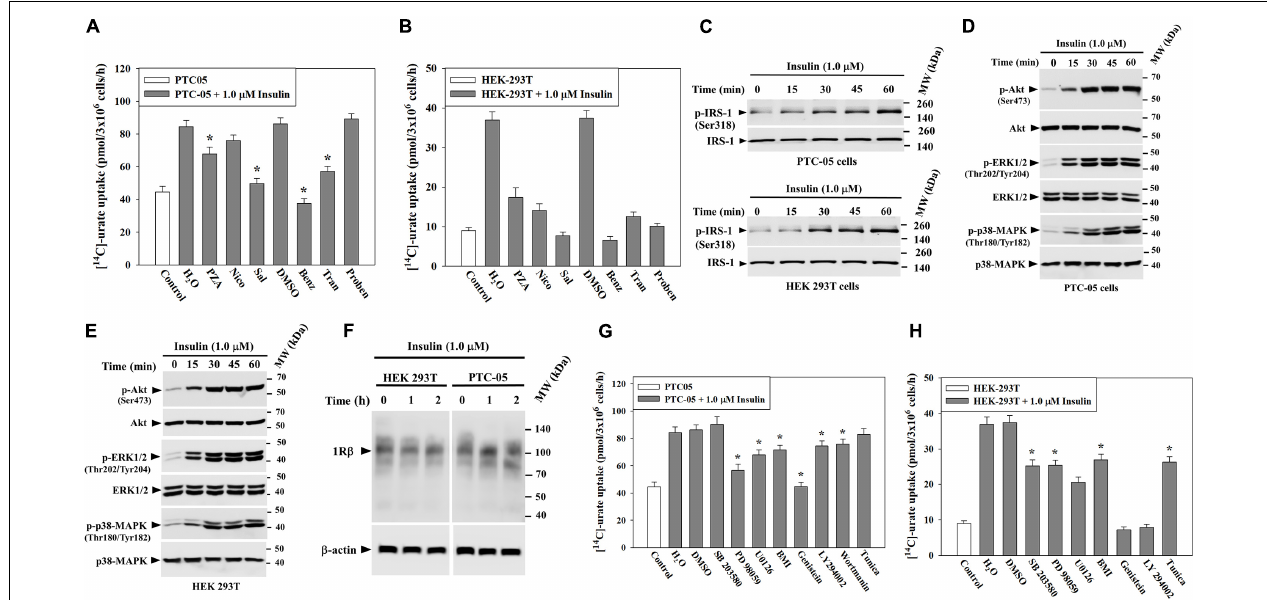
FIGURE 3 | Insulin stimulates urate uptake through activation of PTK (protein tyrosine kinase) of INSR, IRS1, PI3K, Akt, p44/42 MAPK (ERK) and/or p38 MAPK in human kidney cell lines (HEK 293T and PTC-05). (A,B) The stimulatory effect of insulin (1.0 µ M) on [ 14 C]-urate uptake by endogenous urate transporters in equal number (3x10 6 ) of PTC-05 (A) and HEK 293T (B) cells was measured in the absence and presence of 10 mM pyrazinoate (PZA), 10 mM nicotinate (Nico), 10 mM salicylate (Sal), 100 µ M benzbromarone (Benz), 100 µ M tranilast (Tran), or 1.0 mM probenecid (Proben) in the extracellular K + -free isotonic medium at ∼ 25 ◦ C. Uricosuric drugs were dissolved in dimethyl sulfoxide (DMSO). (C–E) Insulin activates IRS1, Akt, ERK and p38 MAPK in PTC-05 cells (C,D) and HEK 293T cells (C,E) . (F) Insulin has no significant effect on the expression of endogenous INSR protein (IR β ; ∼ 96 kDa) expression. For Western blot analyses cells were treated with insulin (1.0 µ M) in K + -free isotonic medium and lysates were analyzed using appropriate antibodies (see methods). (G,H) Signaling pathway-specific inhibitors differentially inhibit insulin-stimulation of [ 14 C]-urate uptake in PTC-05 cells (G) and HEK 293T cells (H) . The effect of insulin (1.0 µ M) on [ 14 C]-urate uptake was measured in K + -free isotonic uptake medium in the absence and presence of the natural protein tyrosine kinase inhibitor (genistein; 75 µ M), phosphatidylinositol 3-kinase (PI3K) inhibitor (LY 294002; 50 µ M), wortmanin (4 µ M), p38 MAPK inhibitor (10 µ M SB 203580), MEK/ERK inhibitor (20 µ M PD 98059 or U0126) or protein kinase C inhibitor (10 µ M bisindolylmaleimide I (BMI). Results are the average of three independent experiments ± s.e.m. Asterisk (*), P < 0.001 compared with urate uptake in the absence of uricosuric drugs, anti-uricosuric agents or in presence of insulin and